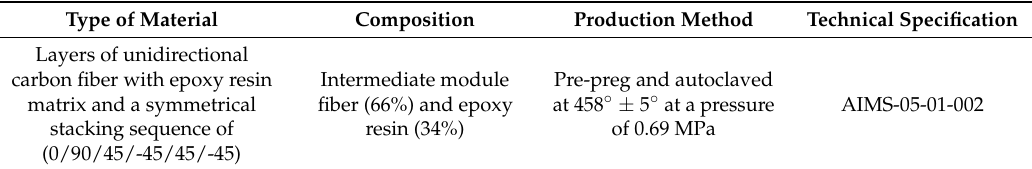
Table 2. Carbon Fiber Reinforced Plastic (CFRP) pieces features.